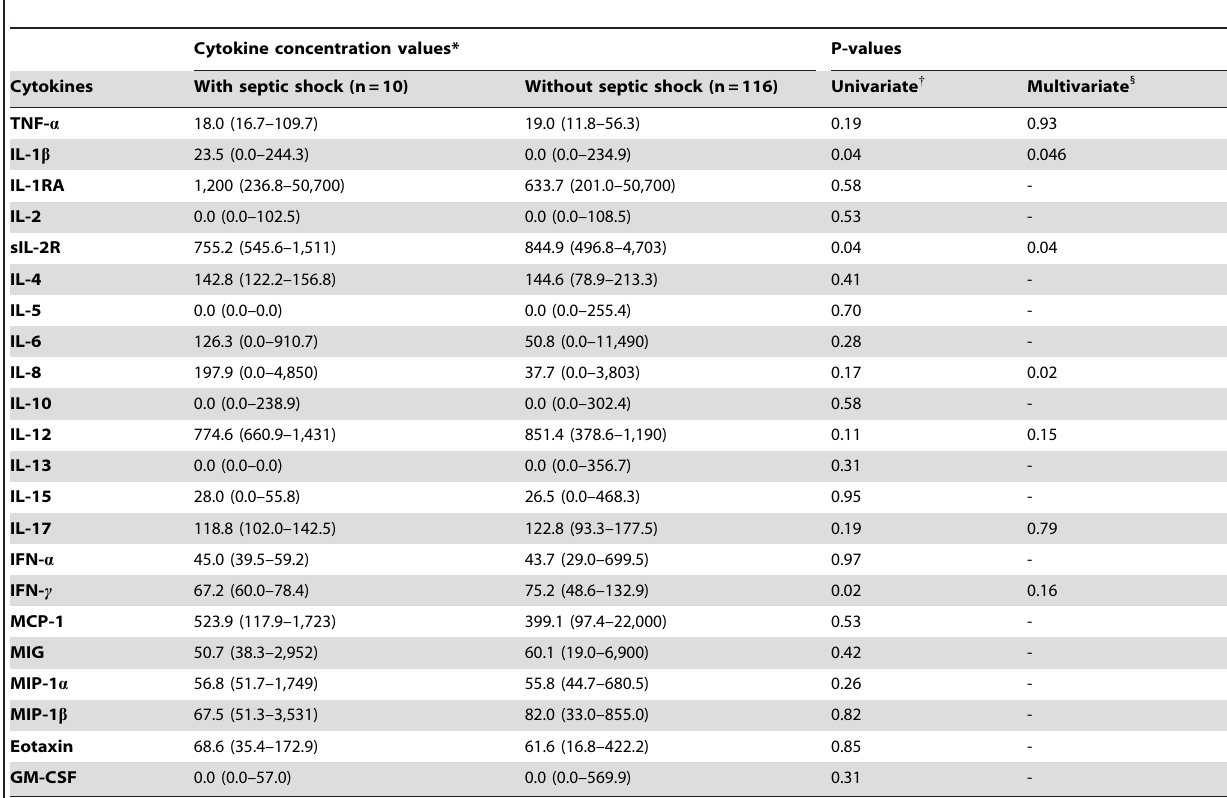
Cytokine concentration values*